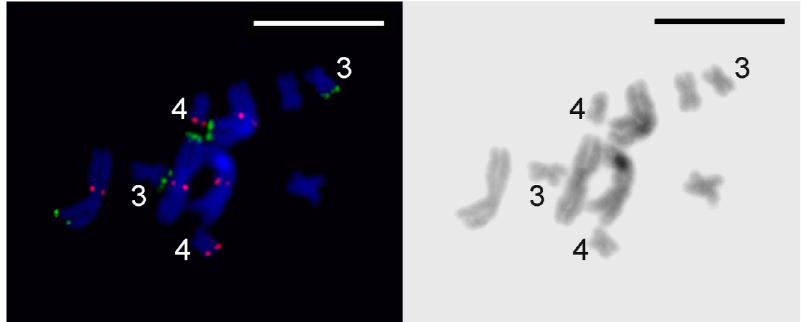
Figure 5. Localization of the 28S rDNA cluster (green) and the unique DNA fragment R4 (red) in chromosomes of M. lignano . The image with inverted DAPI staining is to the right of the FISH image. Metaphase chromosomes were stained with DAPI (blue). Scale bar: 10 µm.